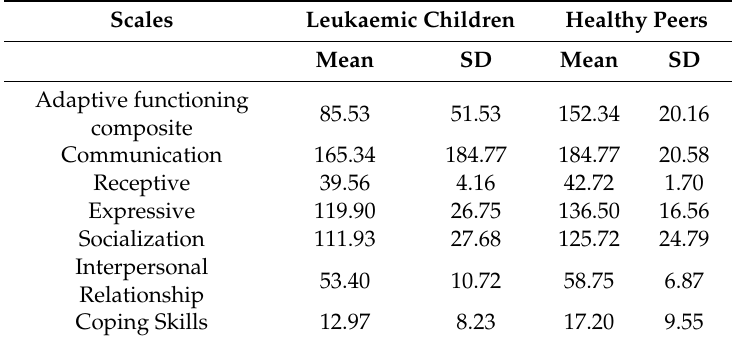
Table 2. Adaptive functioning in children with leukemia and healthy controls: Mean and standard deviations.